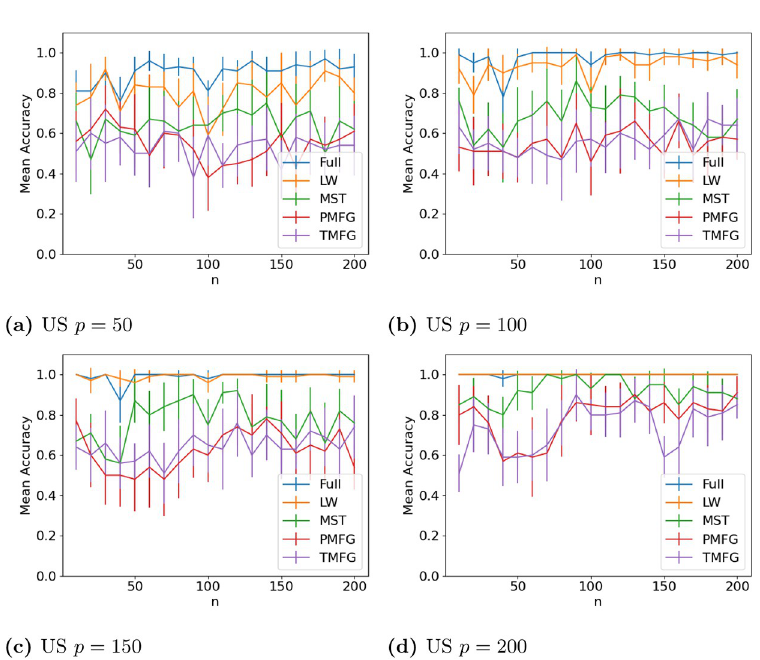
Fig 15. Accuracy when distinguishing between correlation matrices inferred from adjacent time windows based on the median volatility using the SF method and a random forest classifier for US stock returns. (a) US p = 50, (b) US p = 100, (c) US p = 150, (d) US p =